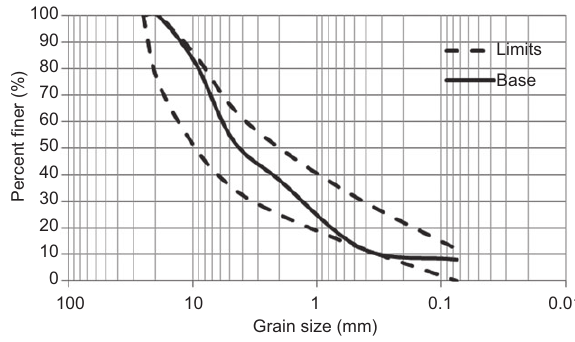
Figure 1 Grain size distribution of base material between limits of Turkish Highways